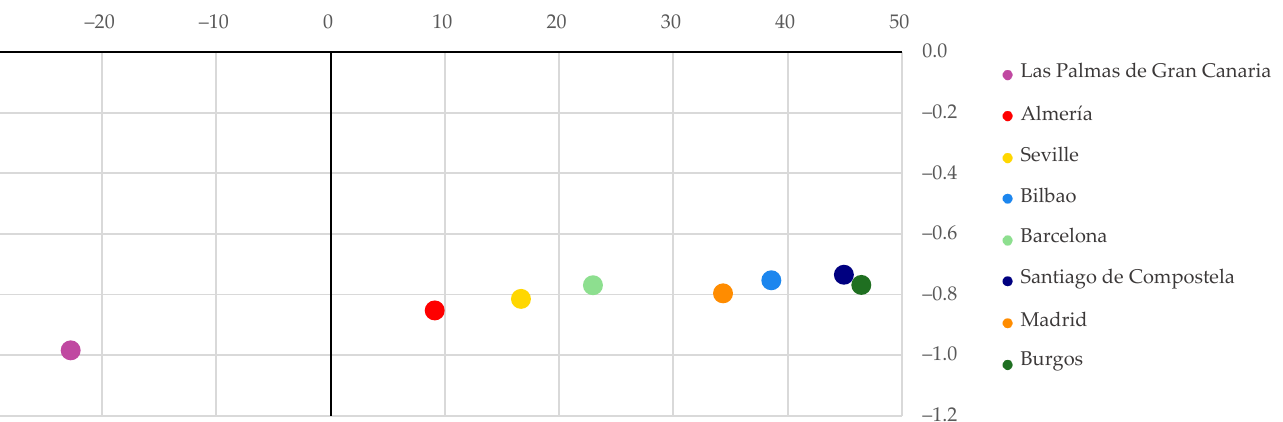
Figure 7. Total energy savings (%) of model B in relation to the reference model regarding heat losses by evapotranspiration (W/m 2 ) in each of the 8 cities.